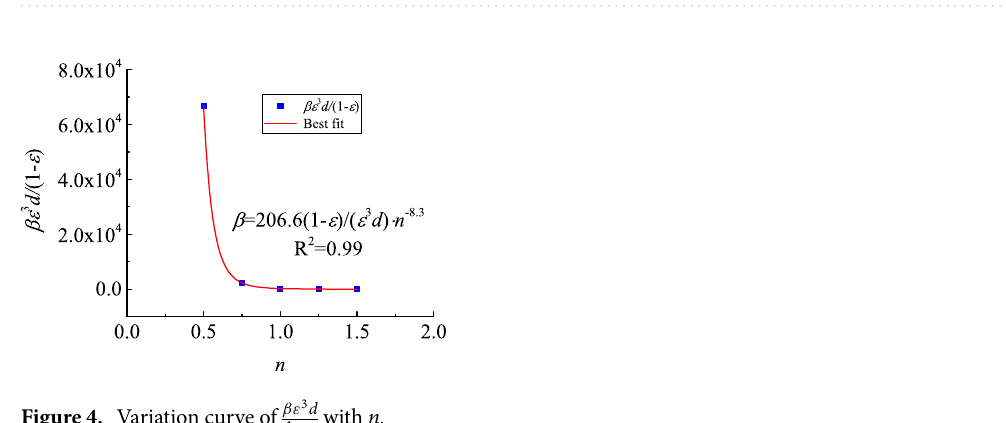
k ( 1 − ε) 2 with n. ε 3 d 2